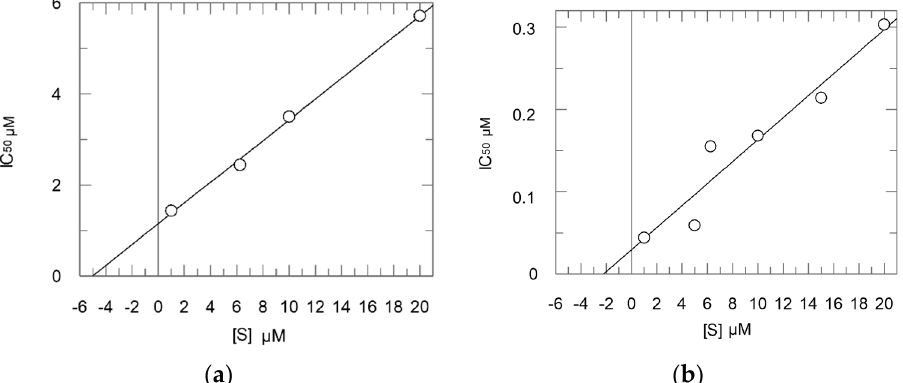
Figure 1. Dependence of inhibition potency (IC 50 values) from substrate concentration for inhibition of cathepsin L by compounds 1 (left) and 2 (right). Increasing IC 50 values at increasing substrate concentrations prove competitive inhibition; the K i(*) value (corresponding to the IC 50 value at zero substrate concentration) is obtained as the intercept of the regression line with the y -axis ( 1 : K i = 1.14 µM and 2 : K i* = 0.030 µM).